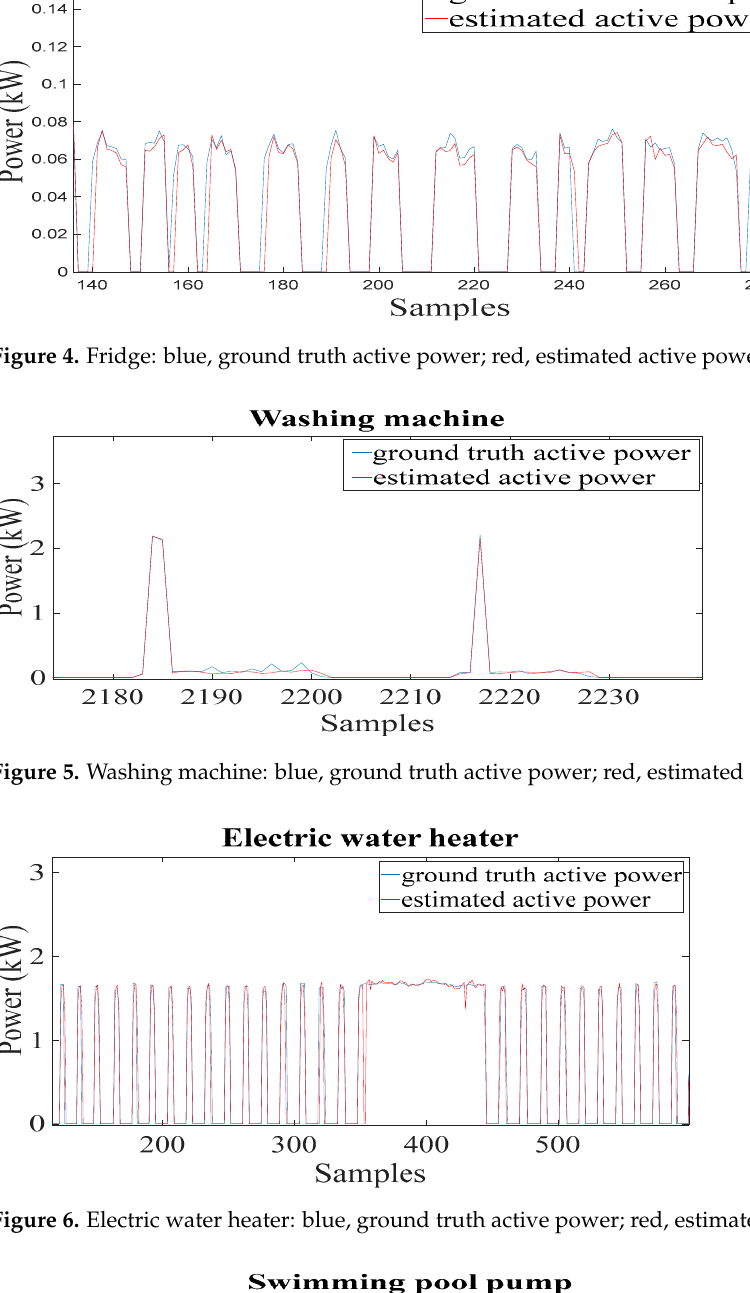
Figure 6. Electric water heater: blue, ground truth active power; red, estimated active power.